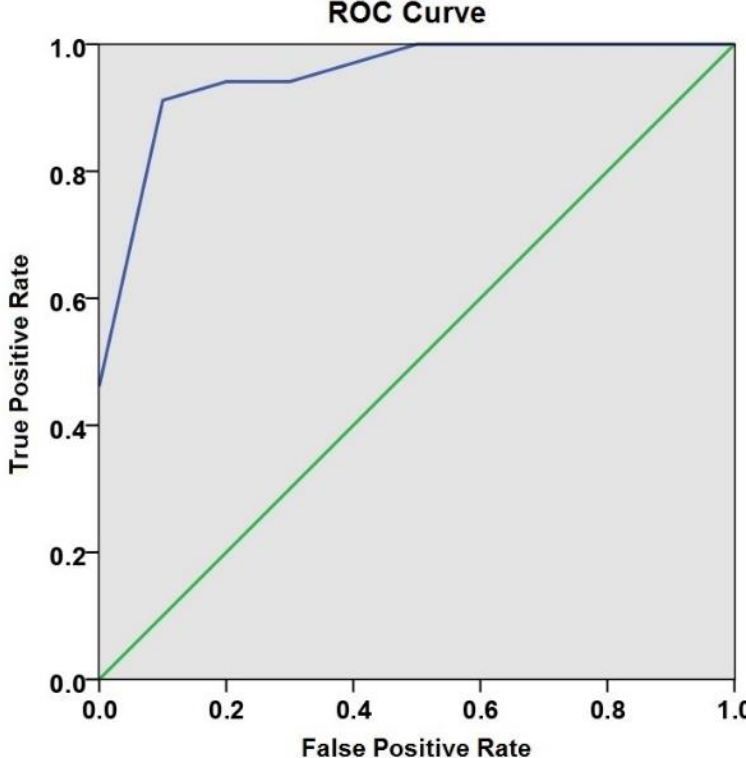
Figure 17. Receiver operating characteristic (ROC) curve between the flood hazard values collected from the field study and the values extracted from the flood hazard map.